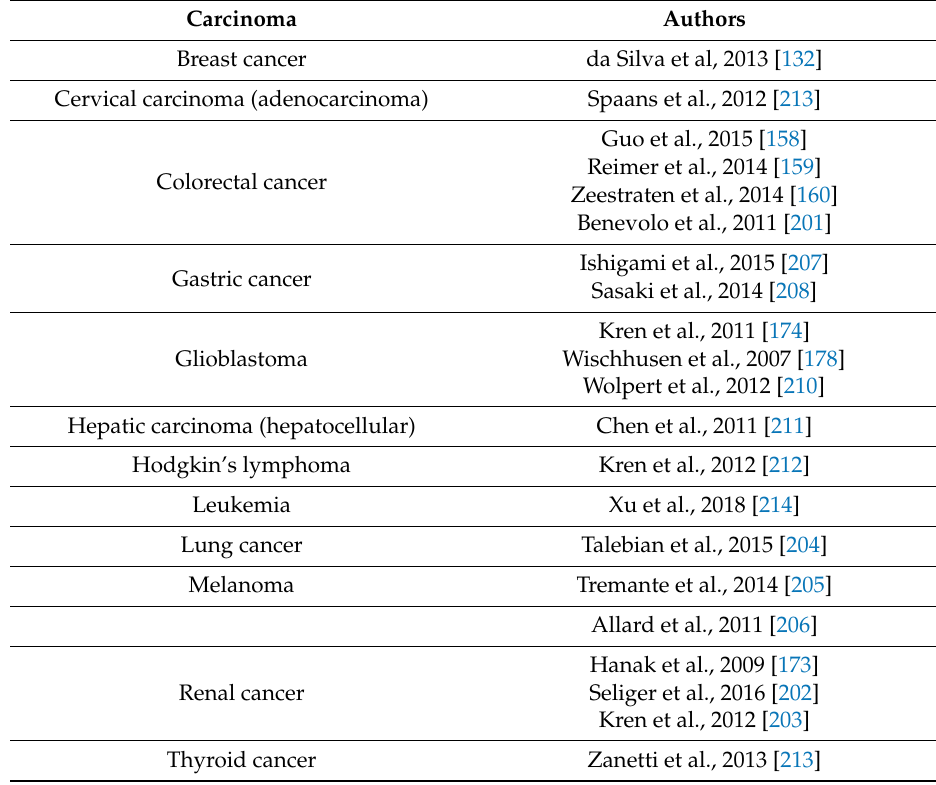
Table 3. Selected literature proving expression of HLA-E on malignant